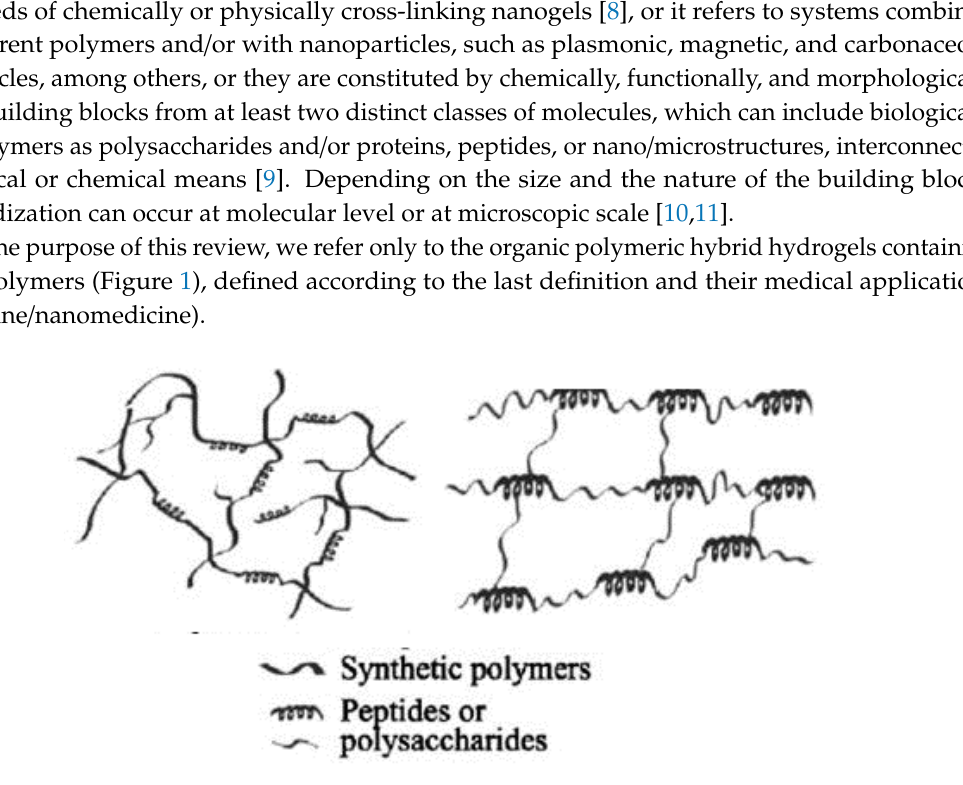
Figure 1. Schematic representation of organic hybrid hydrogels systems [adapted from 11].